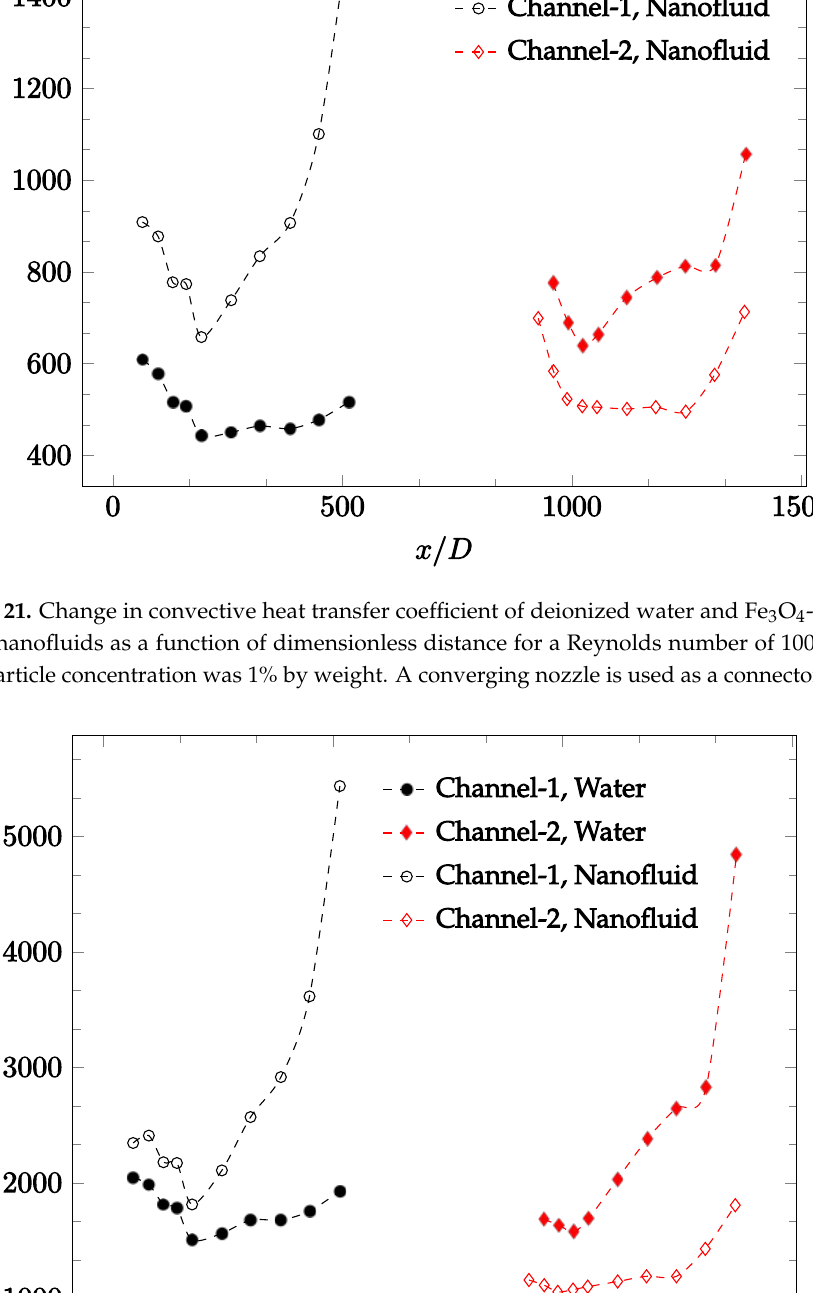
Figure 22. Change in convective heat transfer coefficient of deionized water and Fe 3 O 4 -deionized water nanofluids as a function of dimensionless distance for a Reynolds number of 200–236. The nanoparticle concentration was 1% by weight. A converging nozzle is used as a connector.